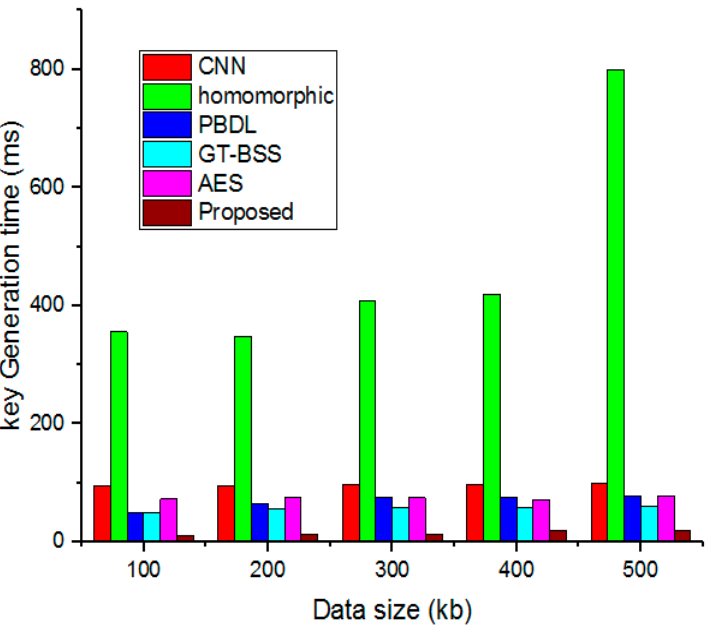
Figure 7. Comparative analysis of key generation.